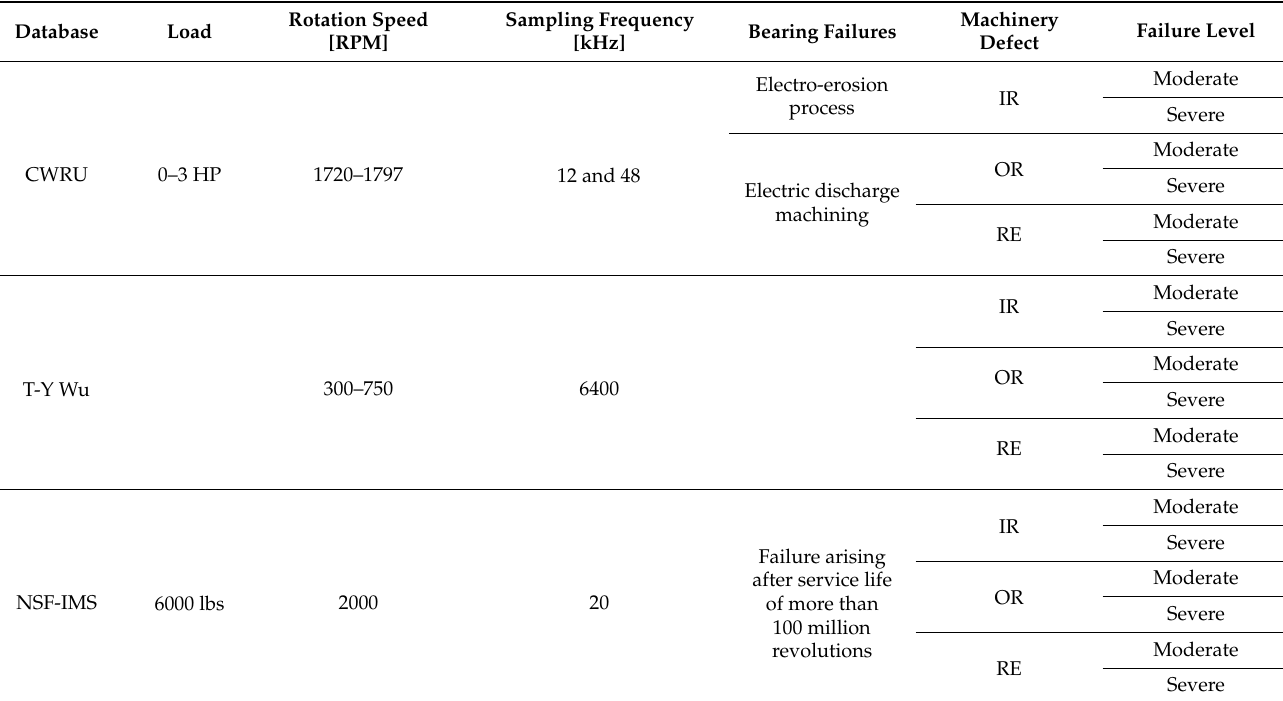
Table 2. Databases to evaluate the proposed method based on